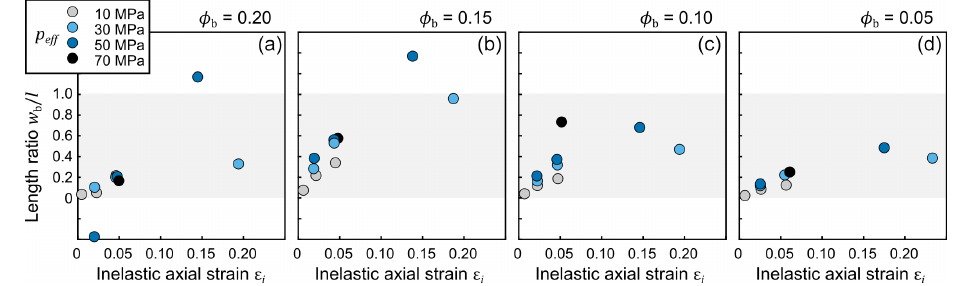
Figure 5. Calculated sample length ratio w b /l as a function of inelastic axial strain accumulation ε i . Values of w b calculated from Eq. (4) using values of compaction band porosity of φ b = 0.20 (a) , φ b = 0.15 (b) , φ b = 0.10 (c) , and φ b = 0.05 (d) . Shaded area indicates range of physical values of w b /l